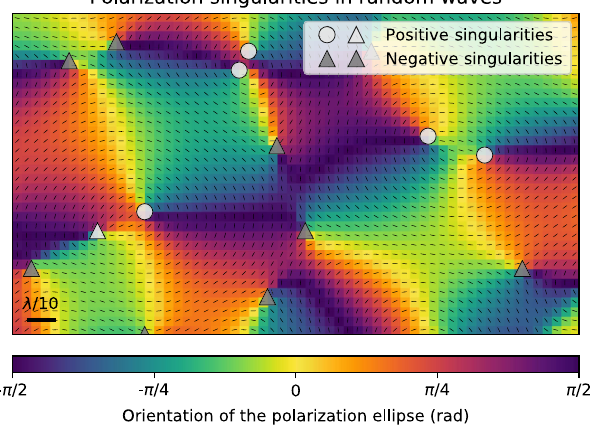
FIG. 2. False-color map for the orientation of the major axis of the polarization ellipse. The black directors indicate the orienta- tion of such an axis, too. The plot is representative of a subsection of the measured optical random field. Circles and triangles are C points. The white and gray symbols denote positive and negative topological indices, respectively. The shape of the symbols, triangles or circles, denotes a star-type or lemon-type classifica- tion, respectively.